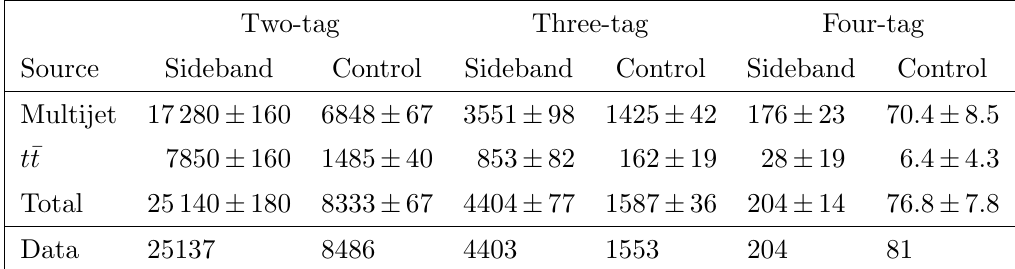
Table 5. The number of events in data and predicted background yields in the sideband and control regions of the two-tag, three-tag and four-tag samples for the boosted analysis. The numbers of multijet and t (cid:22) t background events in the sideband regions are constrained by the number of observed events, as explained in the text. The uncertainties are statistical, with (cid:12)t uncertainties included for backgrounds. The anti-correlation between the multijet and t (cid:22) t yields is accounted for in the uncertainty in the total background